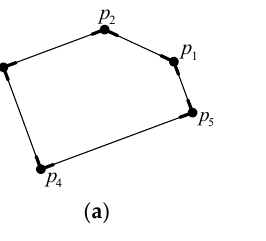
Figure 5. ( a ) Edged corner features derived from a model, and ( b ) information to be stored in a hashing table (dotted lines represent context features).